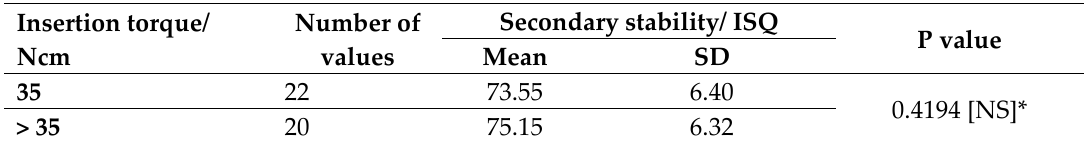
Table (4): The differences of the secondary stability ISQ value between the DI that were installed with an IT of 35 and > 35 Ncm.